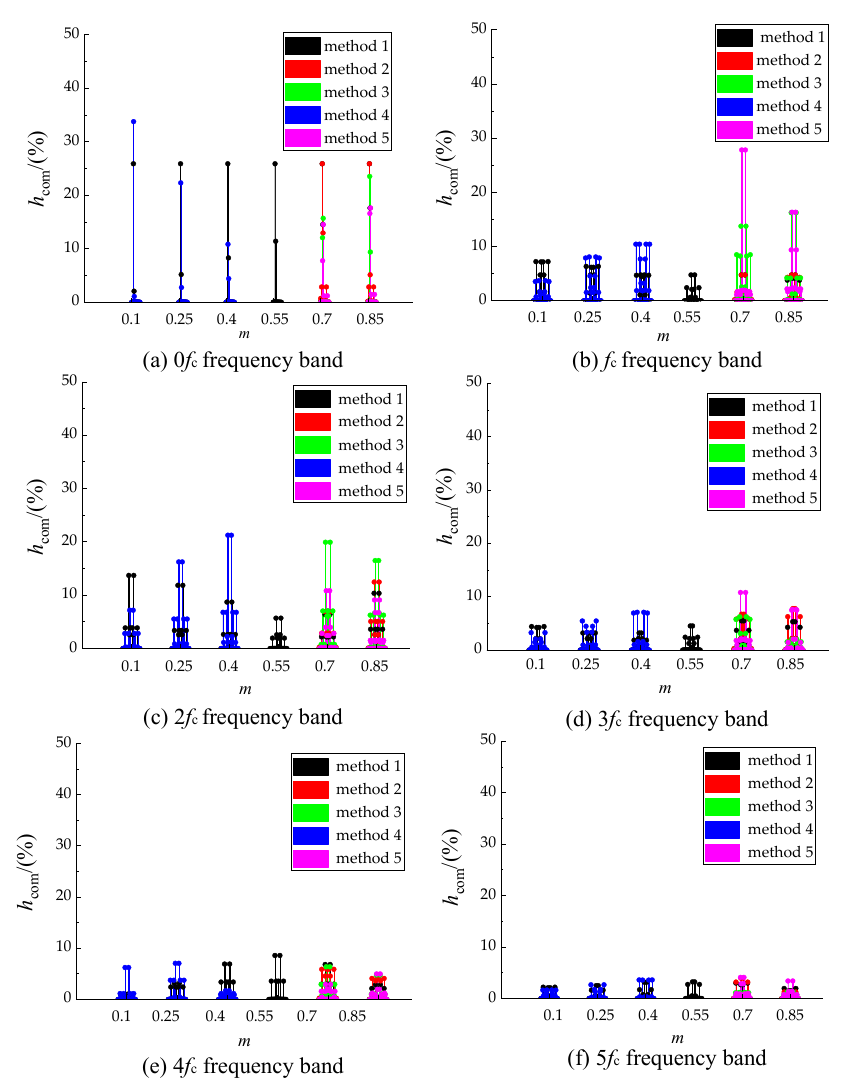
Figure 16. Spectrum of common-mode components with m.